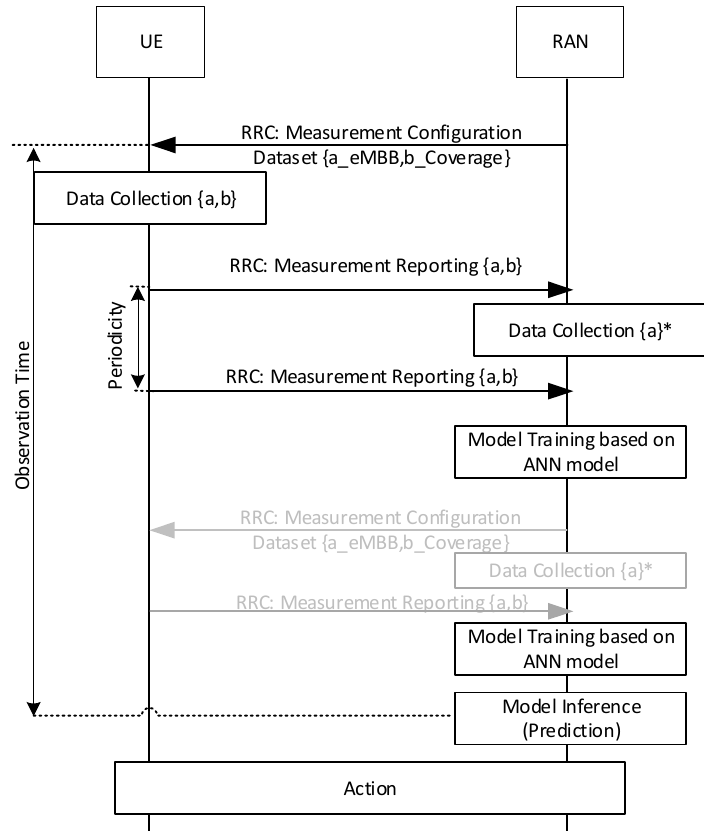
Figure 9. The model for training data collection for coverage optimization for eMBB traffic.